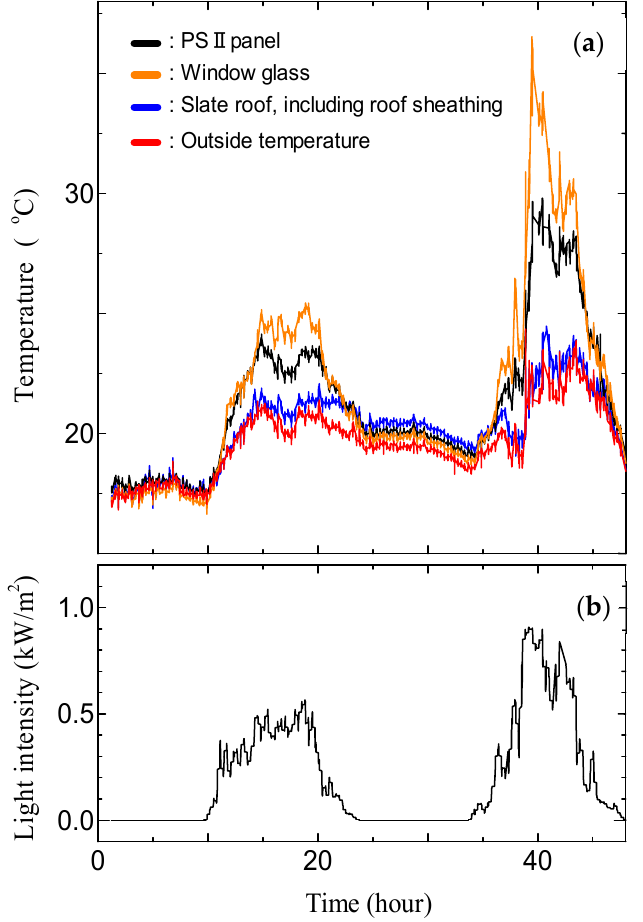
Figure 9. Typical daily temperature change of the front and back surfaces of the PSII roof ( a ) and light intensity by sunshine ( b ).